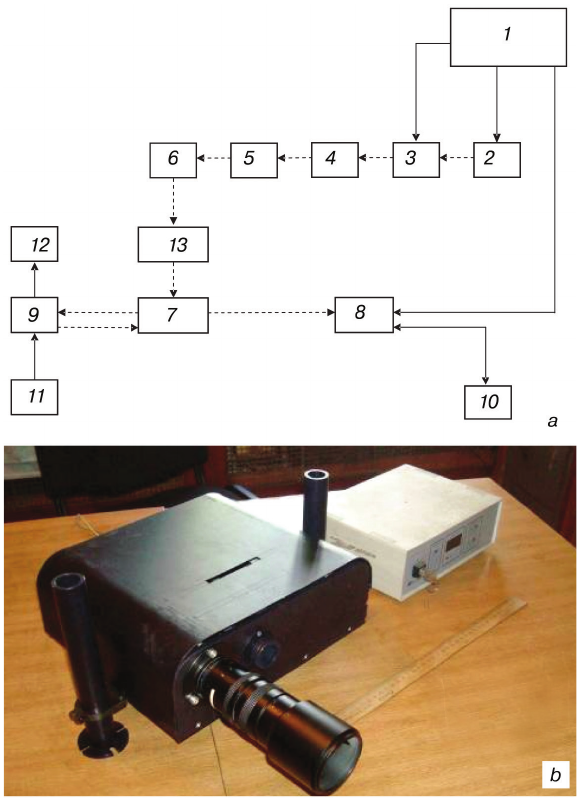
Figure 2. ( a ) Schematic diagram of experimental setup and ( b ) general appearance of digital holographic